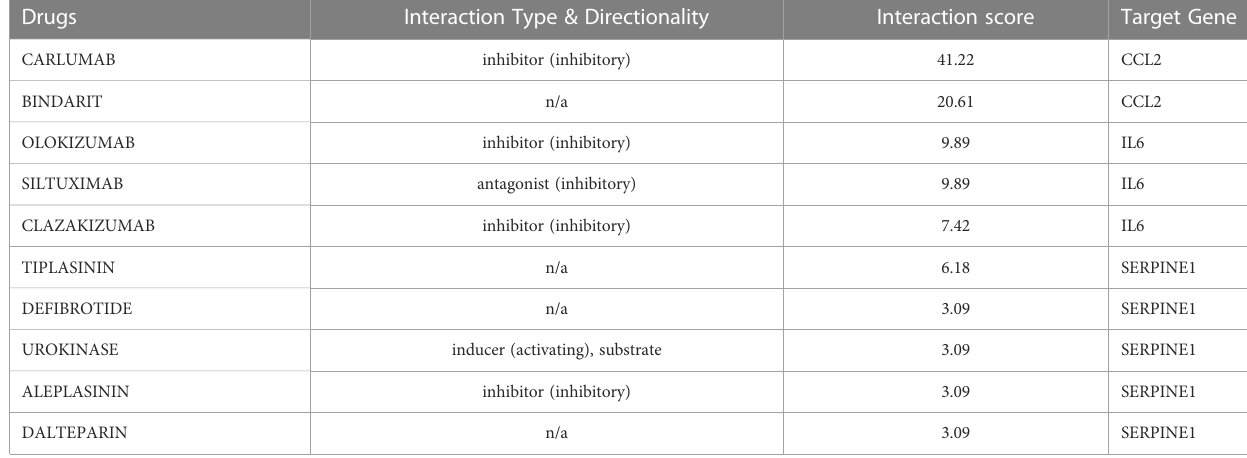
TABLE 4 Top ten drugs screened in DGIdb based on score ranking.